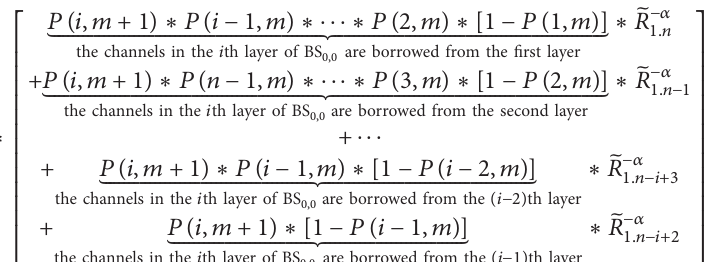
layer ( 𝑗 = 1, . . . , 𝑖 − 1 ), and the channels in the 𝑗 th layer are lent to ( 𝑛 + 1 − 𝑖 )th ( 𝑗 = 1 . . . , 𝑛 − 𝑖 ) layer of BS 1,0 . Therefore,